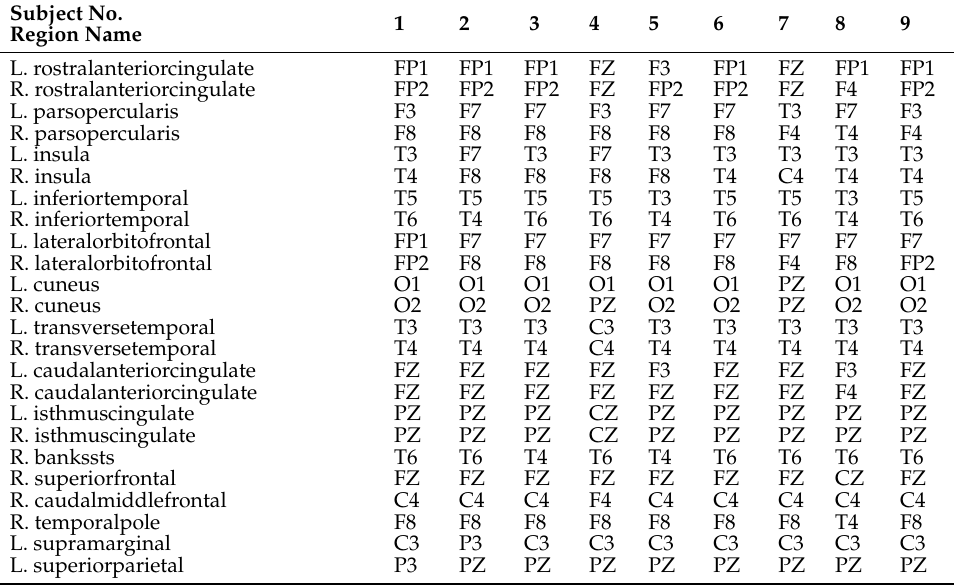
Table 2. Between patient region variance in the region to electrode